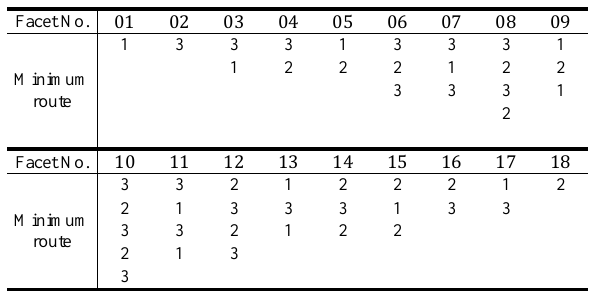
Table 7. The shortest distance from 00 facet to all the triangle facets.